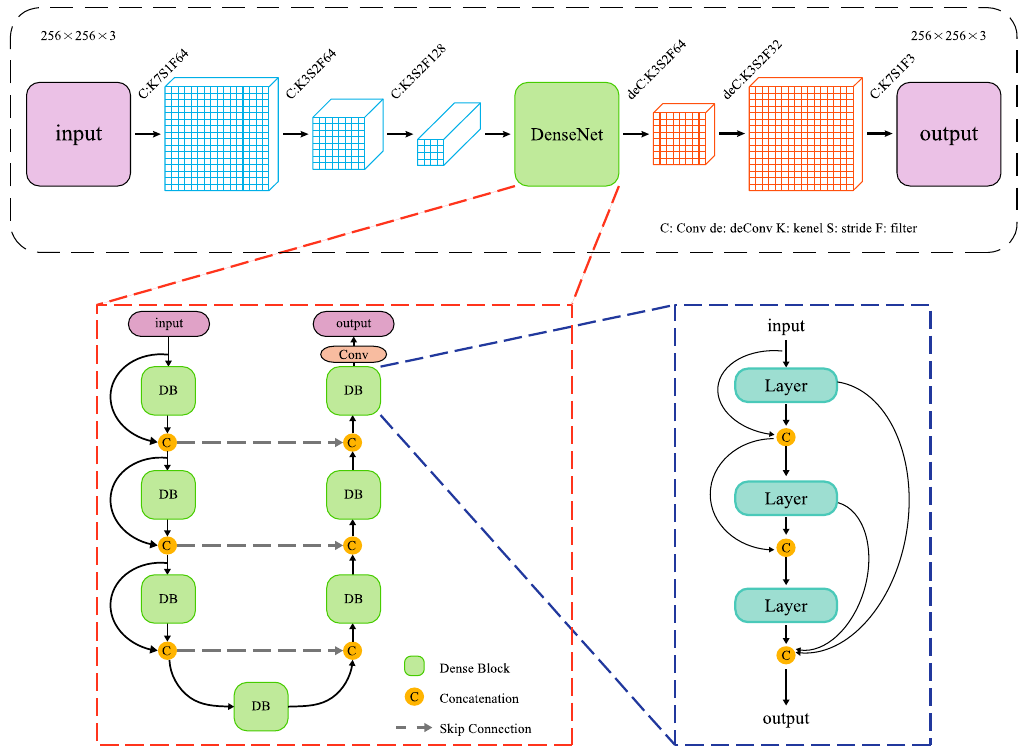
Figure 2. Structure of the generation network and DenseNet.